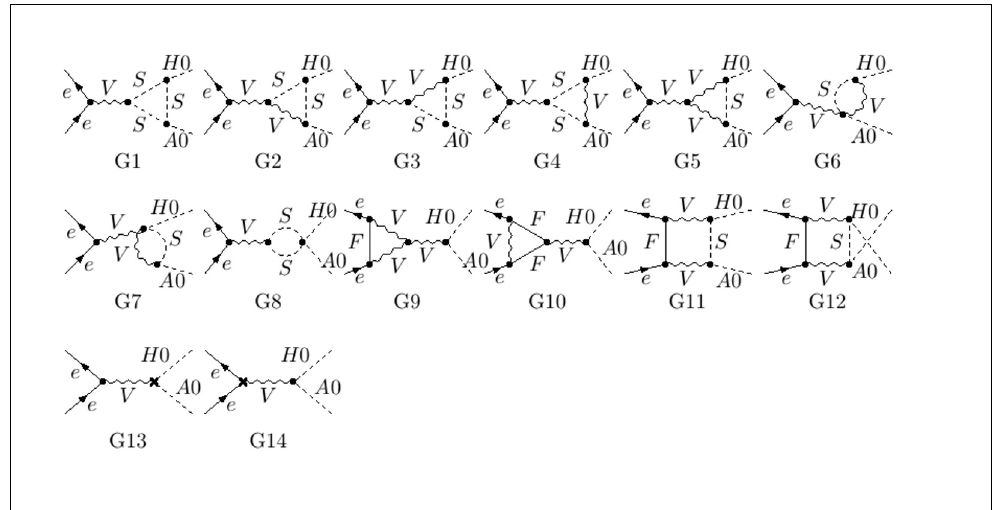
Figure 7 . Generic one-loop Feynman diagrams for e + e − → H 0 A 0 where F stands for SM fermions, V stands for generic vector boson which could be γ , Z or W ± and S could be either a Goldstone G 0 , G ± or a Higgs boson h 0 , H 0 , A 0 or H ±